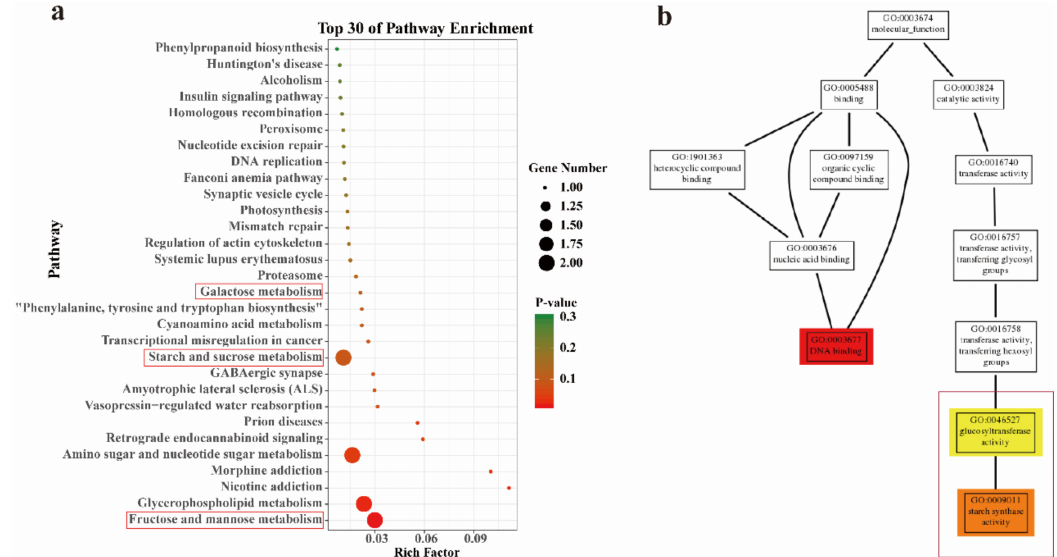
Figure 10. GO and Kyoto Encyclopedia of Genes and Genomes (KEGG) pathway enrichment of module sienna3. ( a ) Top 30 of KEGG pathway enrichment. ( b ) Thumbnails view of directed acyclic graph (DAG) on molecular function of module sienna3.